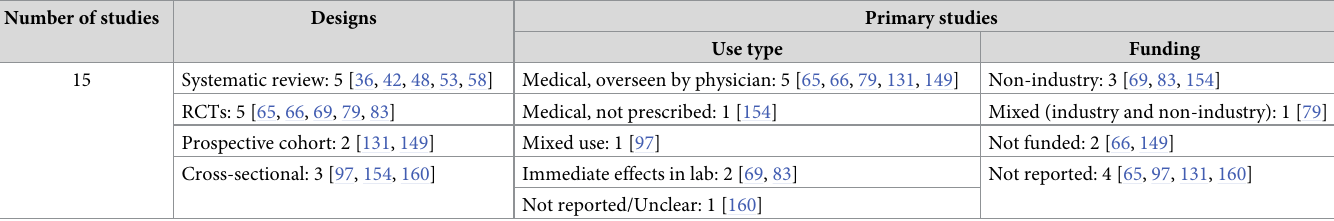
Table 6. Characteristics of studies evaluating the impacts of cannabis use in individuals with Parkinson’s disease. Number of